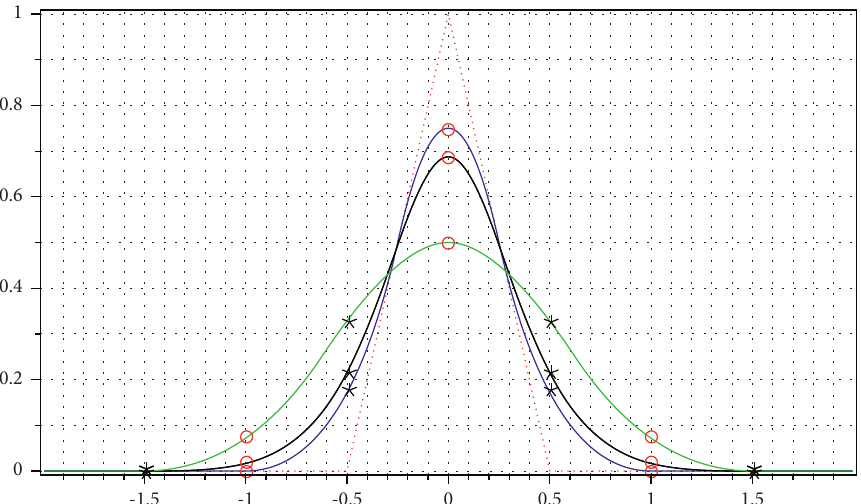
Figure 2: Basic limit functions produced by the 3-point scheme corresponding to S the initial polyline and the blue, black, and green lines represent the basic limit function produced with w � − ( 1/12 ) , 0 , ( 3/12 ) , respectively. The circles denote the evaluations of the basic limit function at integers; the asterisks denote the evaluations of the basic limit function at half integers.